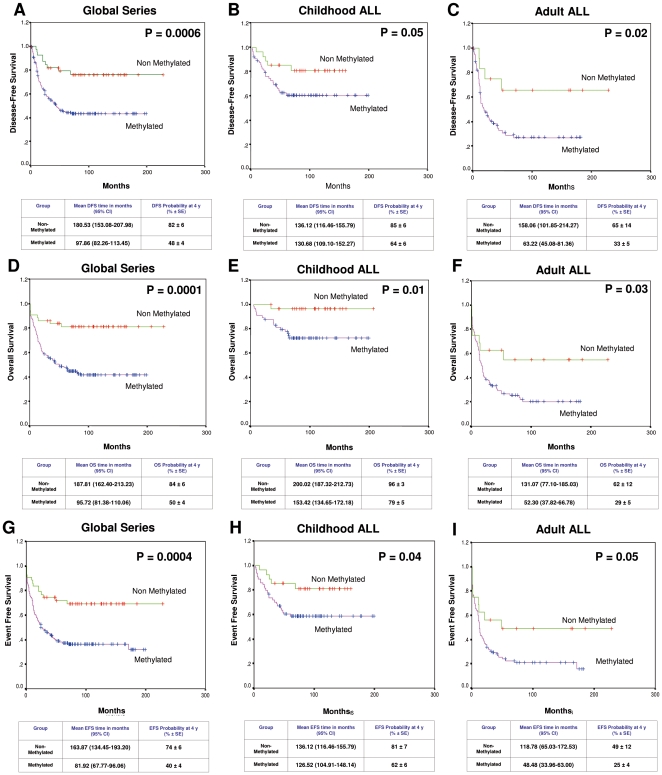
Survival curves of Kaplan-Meier.DFS curves for all patients enrolled in this study (panel A), childhood ALL (B) and adult ALL (C) according to the methylation profile. OS curves for all patients enrolled in this study (D), childhood ALL (E) and adult ALL (F) according to the methylation profile. EFS curves for all patients enrolled in this study (G), childhood ALL (H) and adult ALL (I) according to the methylation profile.